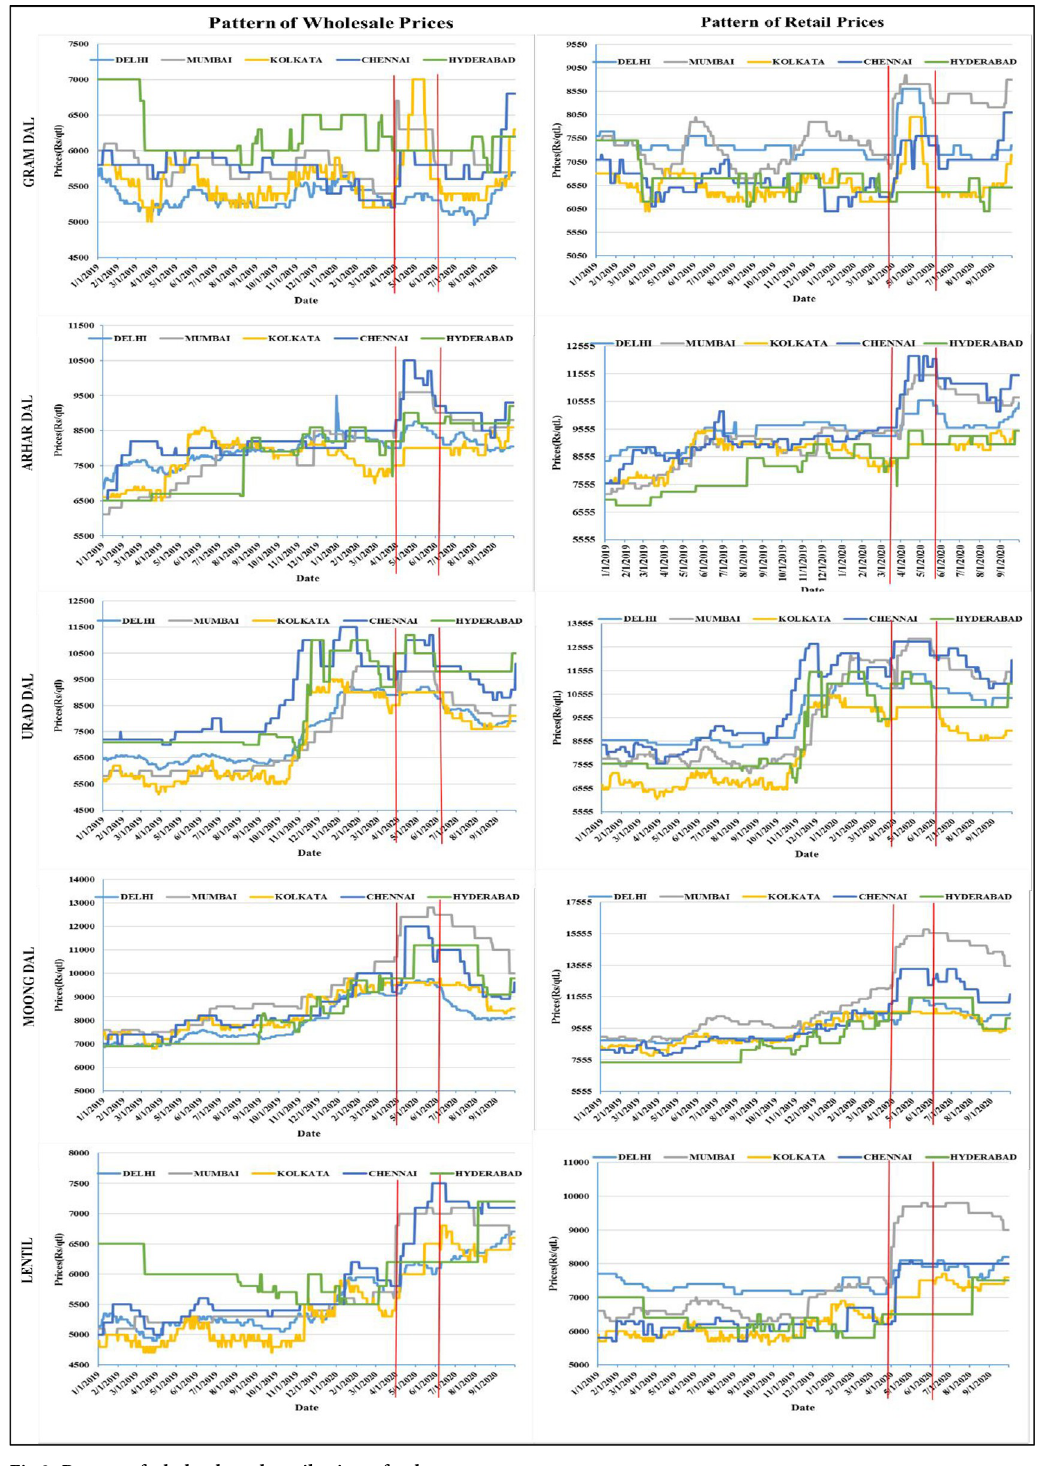
Fig 3. Pattern of wholesale and retail prices of